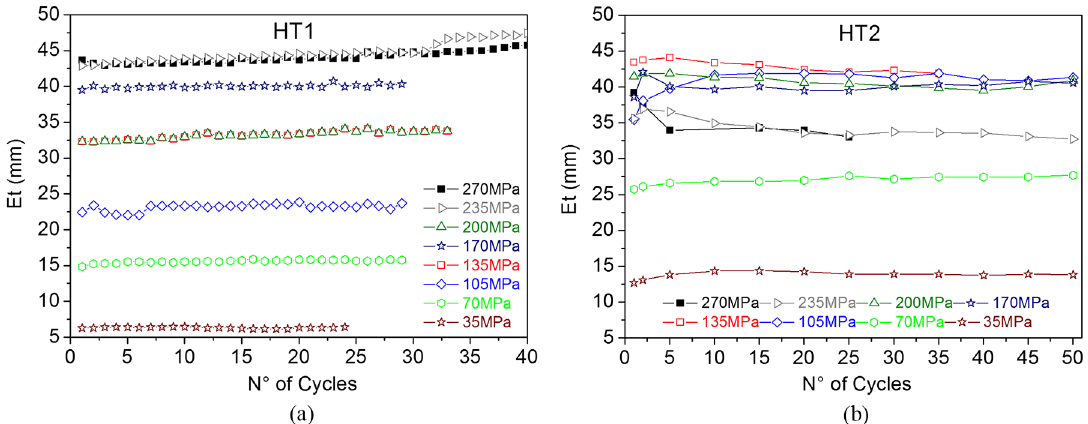
Figure 6. Thermoelastic strain versus number of cycles for 35, 70, 105, 135, 170, 200, 235 and 270 MPa stress. (a) HT1-24h and (b) HT2-24h.